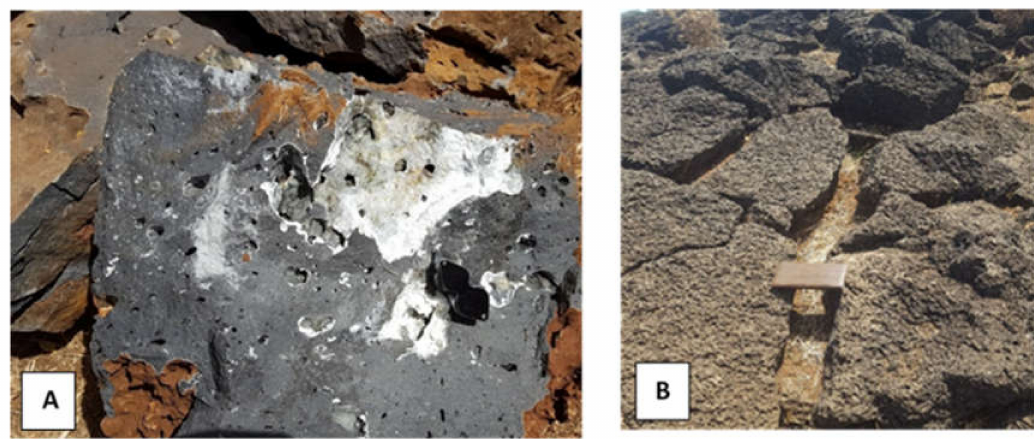
Figure 3. ( A ) Young Quaternary rock with vesicles filled in by zeolites, calcite, quartz, or chalcedony amygdales; ( B ) Blocky fractured vesicular basalt which forms undulating